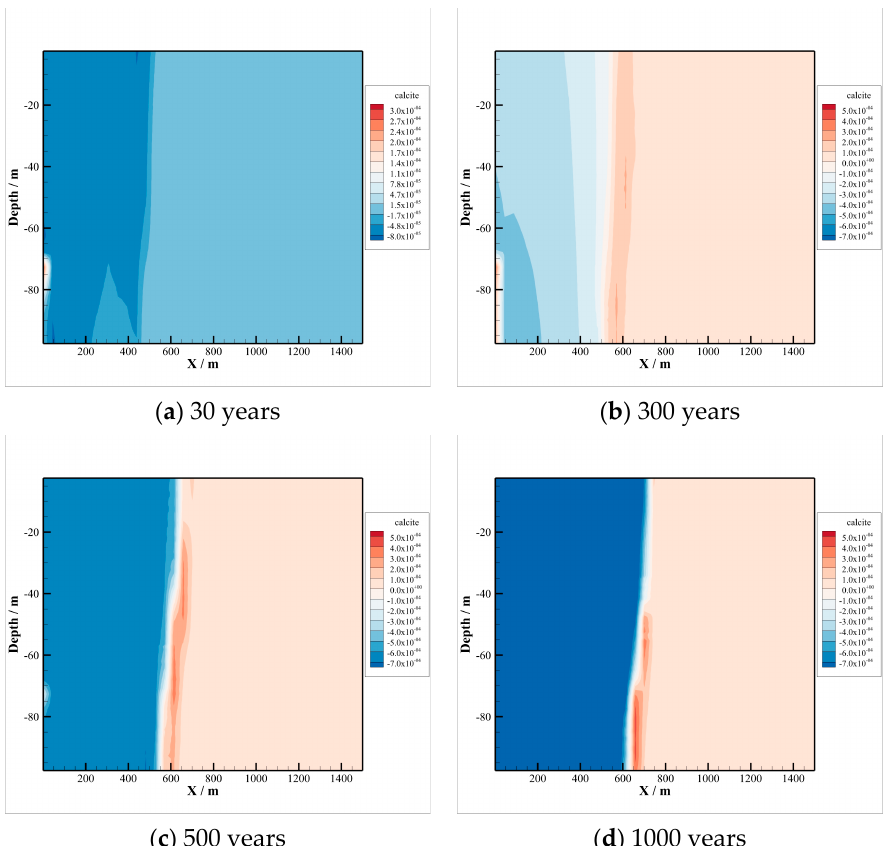
Figure 8. Calcite dissolution and precipitation.